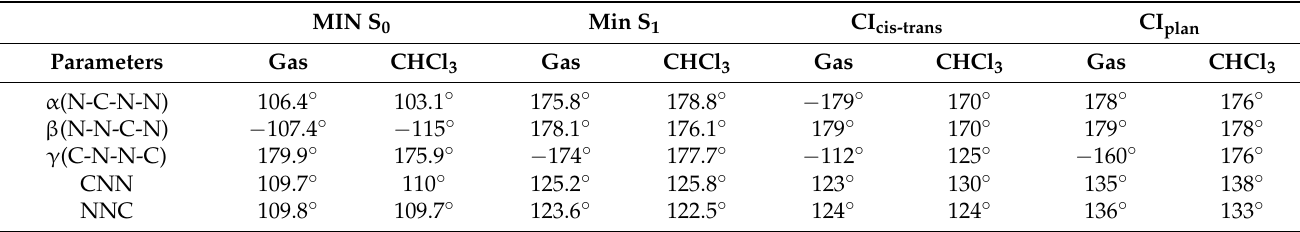
Table 1. Structural parameters obtained at several critical points along the S 0 and S 1 potential energy surfaces of the gas-phase and solvated chromophore. The S 0 minimum was obtained at the MP2/6-31G* level, whereas the remaining points at the SS-CASPT2/SA-2-CASSCF(18,12) level. MIN S 0 Min S 1 CI cis-trans CI